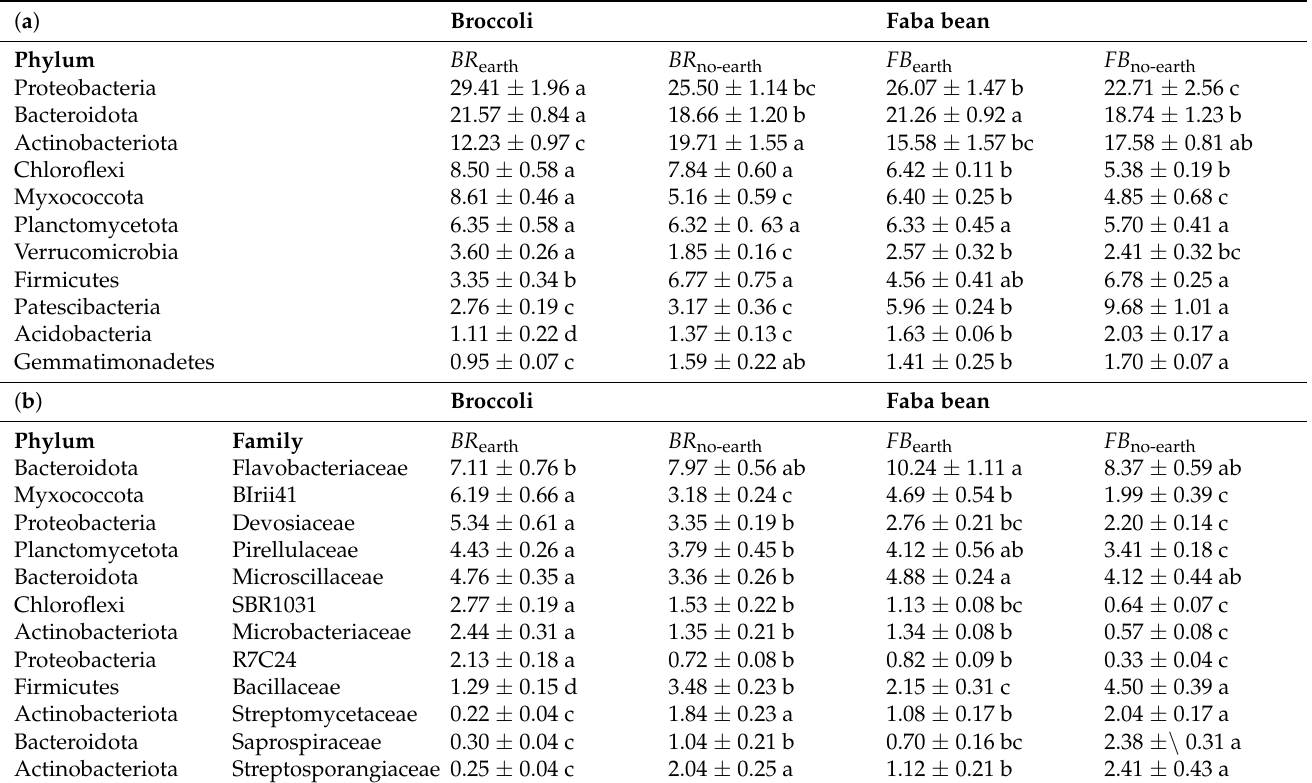
Table 3. Relative abundance of (a) bacterial phyla (relative abundance > 1%) and (b) families (relative abundance > 2% ) in soils under different treatments. Means ( ± standard deviations) in each phylum or family followed by similar letters are not significantly different at 5% probability level (Tukey’s HSD